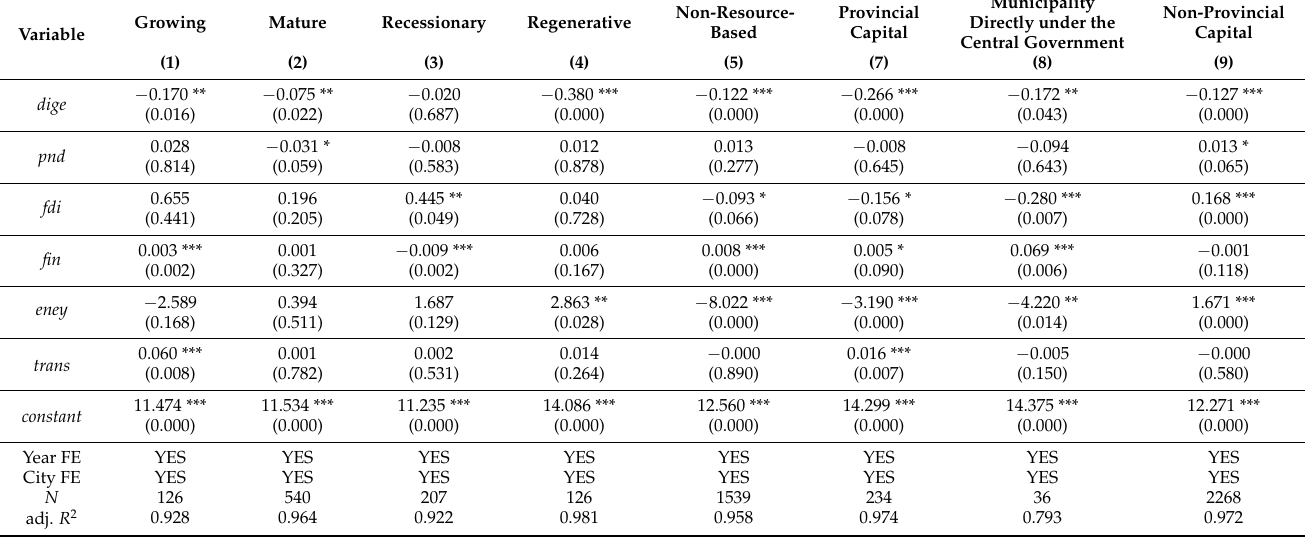
Table 11. City type